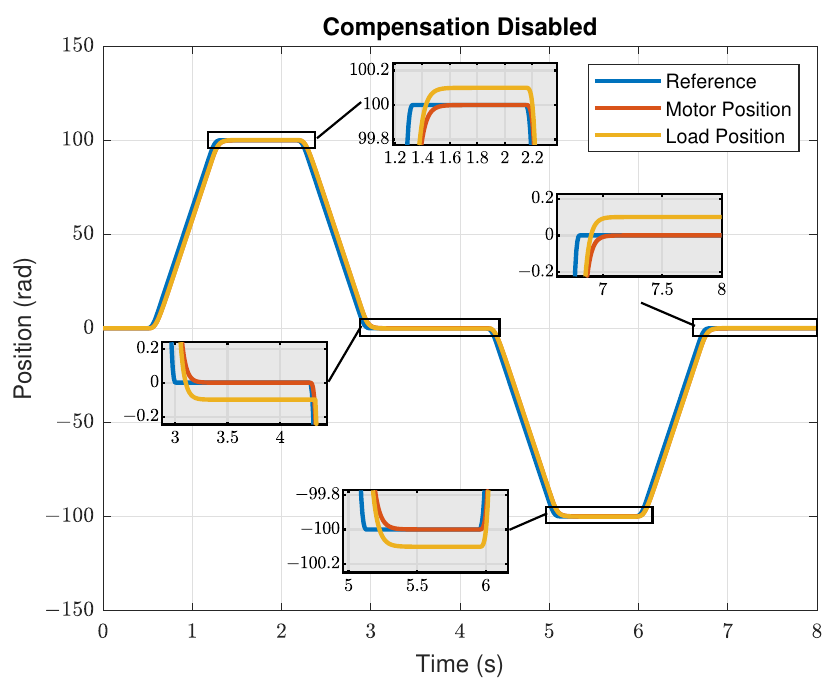
Figure 3. Effectof the mechanical backlash on the servo control.